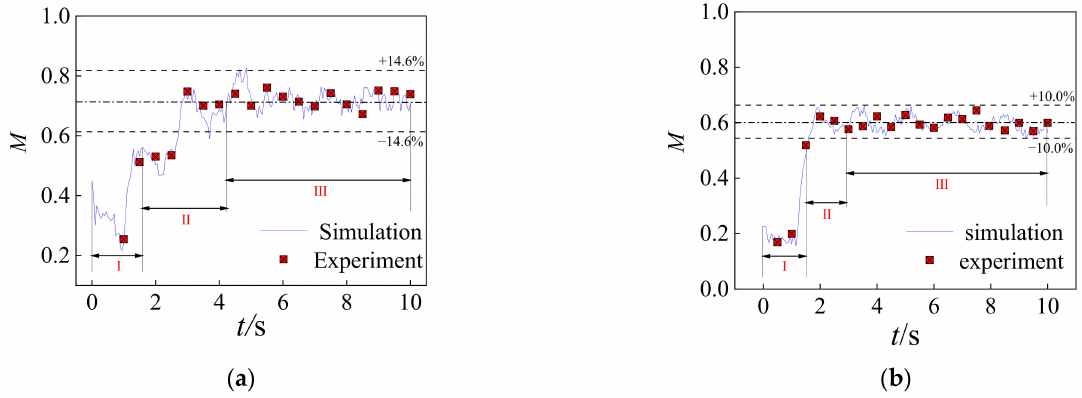
Figure 4. Comparison of the Lacey mixing index between experiment and simulation. ( a ) Ellipsoidal drum; ( b ) circular